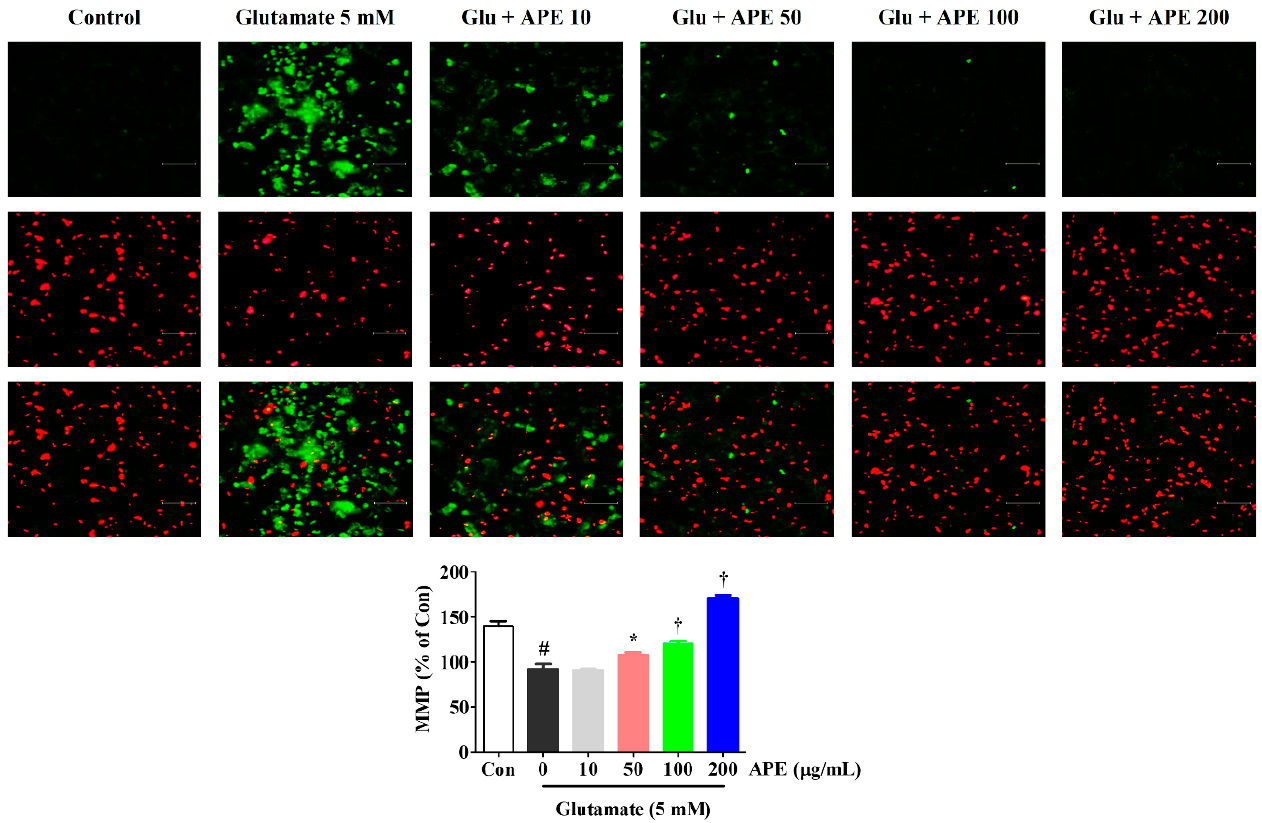
Figure 3. Effects of Arecae Pericarpium ethanol extract on glutamate-induced mitochondrial dys- function in HT22 cells. MMP was assessed via microscopy using JC-1 staining. The images represent the three independent experiments, shown at 200 × magnification. Scale bar = 100 µ m. Red fluores- cence indicated normal MMP and green fluorescence, damaged mitochondria with MMP loss. The histogram shows the red/green fluorescence intensity ratio. Control was non-treated cells. Data were presented as mean ± standard error of the mean. Statistical significance was set at # p < 0.05 (vs. control), * p < 0.05, and † p < 0.001 (vs. glutamate). APE, Arecae Pericarpium ethanol extract; Con, control; Glu, glutamate; MMP, mitochondrial membrane